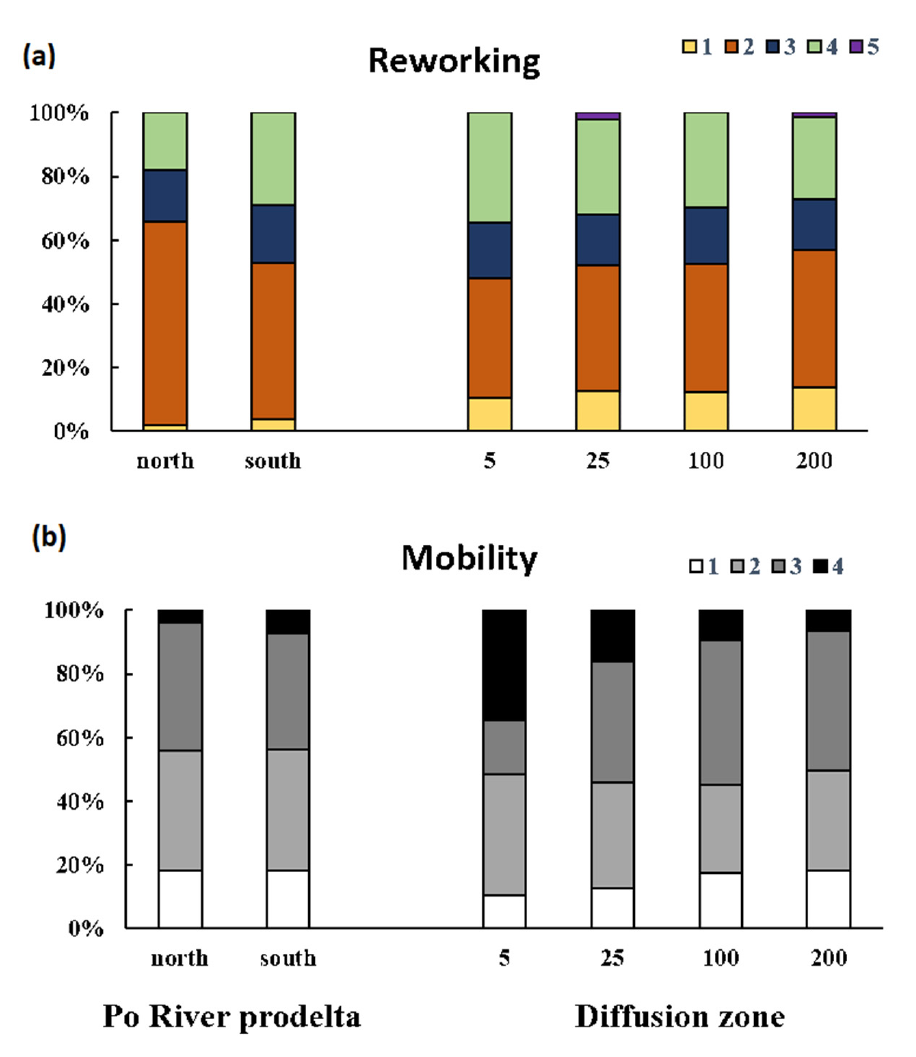
Figure 5. Relative frequencies (%) of scores belonging to reworking ( a ) and mobility ( b ) of bioturba- tion activities of community at north and south for Po River coastal area and at increasing distance from pipelines (<5, 25, 100, and >200 m) in the Gulf of Trieste. See Table S2 for scores. According to the IP c values, relative frequencies (%) indicated the scores belonging to burrow type varied in the coastal area of prodelta. A higher % of ‘infauna with internal irrigation’ score in northern stations (34.0%), whereas the increasing value of the ‘blind-